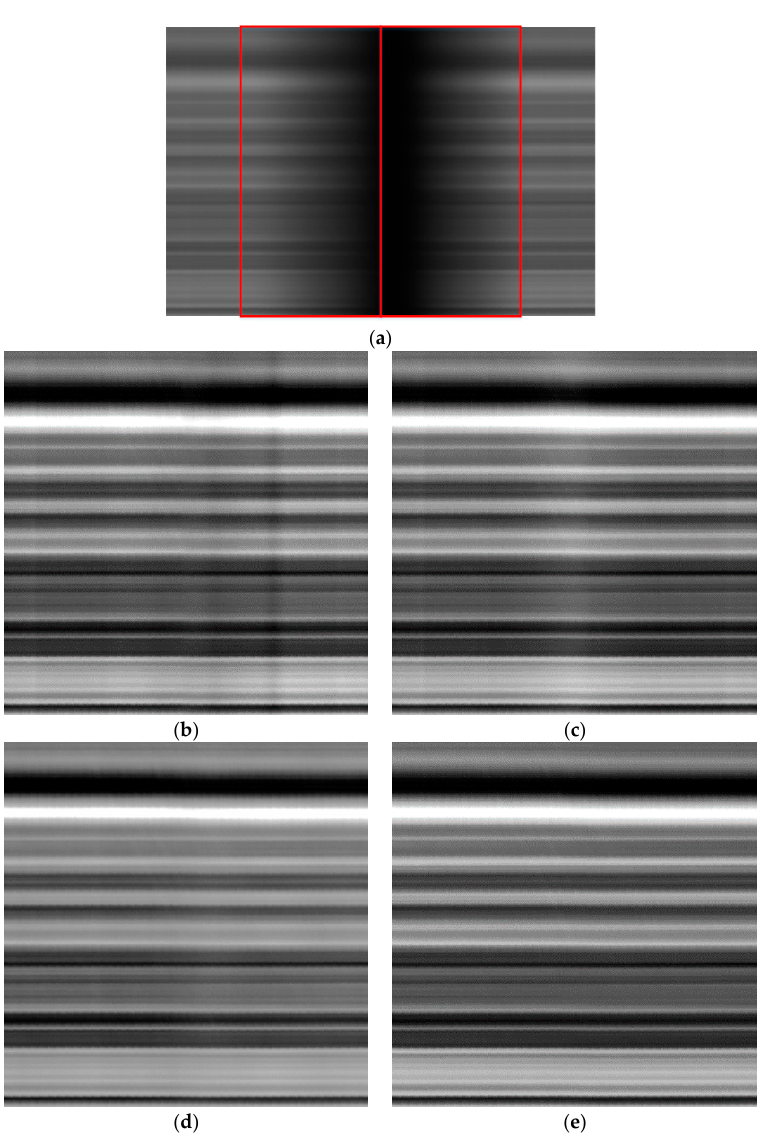
Figure 12. Corrected images of the middle brightness region of the side-slither data (the images were stretched for display): ( a ) raw data for the low-brightness region; ( b ) results obtained using polynomial fitting; ( c ) results obtained using laboratory coefficients; ( d ) results generated using on-orbit coefficients; ( e ) results generated using coefficients obtained by the proposed method.